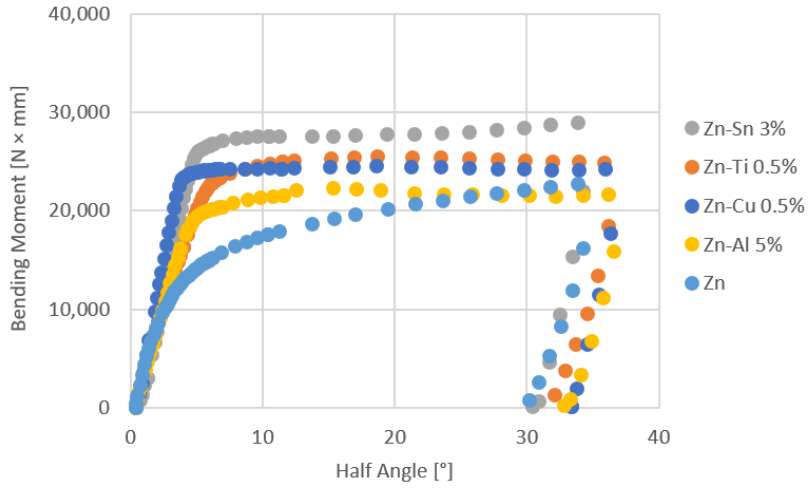
Figure 8. Bending tests results for all specimens investigated for 900 s dipping time.